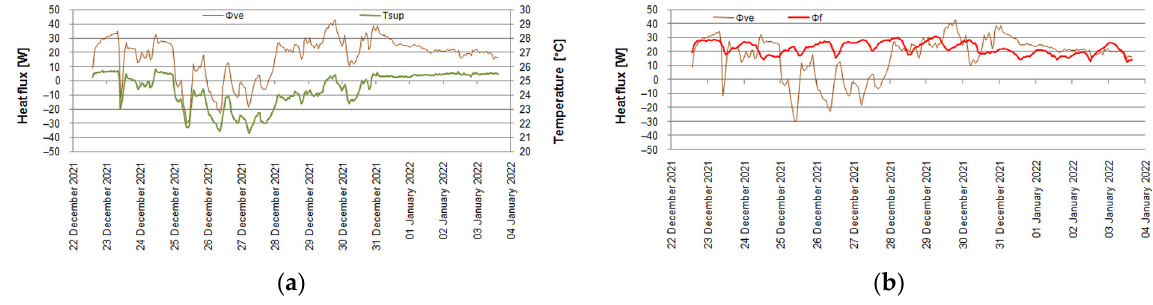
Figure 7. Measurement results: ( a ) Calculated ventilation heat flux and supplying air temperature; ( b ) Calculated ventilation heat flux and measured floor heat flux. Ventilation heat flux ranged from − 30 W (10:00 on 25 December) to 42.7 W (19:00